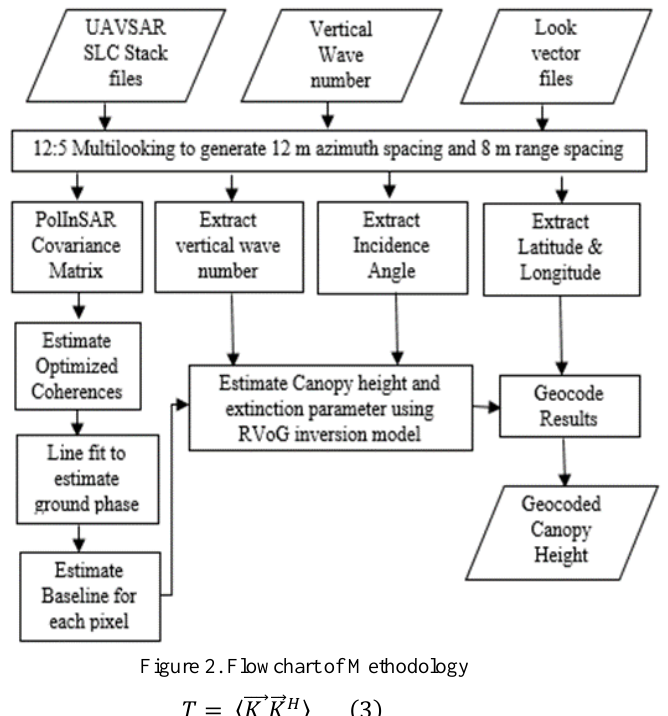
Figure 2. Flowchart of